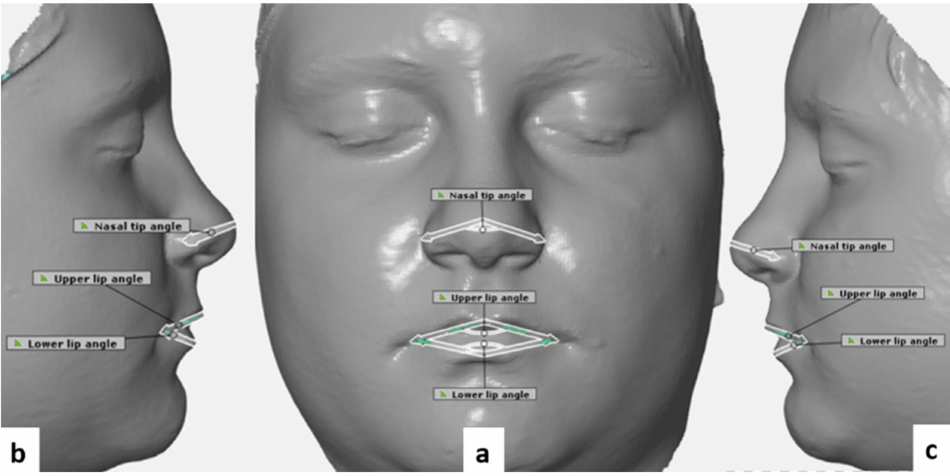
Figure 4. Angular measurements used in our study. ( a ) Frontal view ( b ) and ( c ) lateral views.